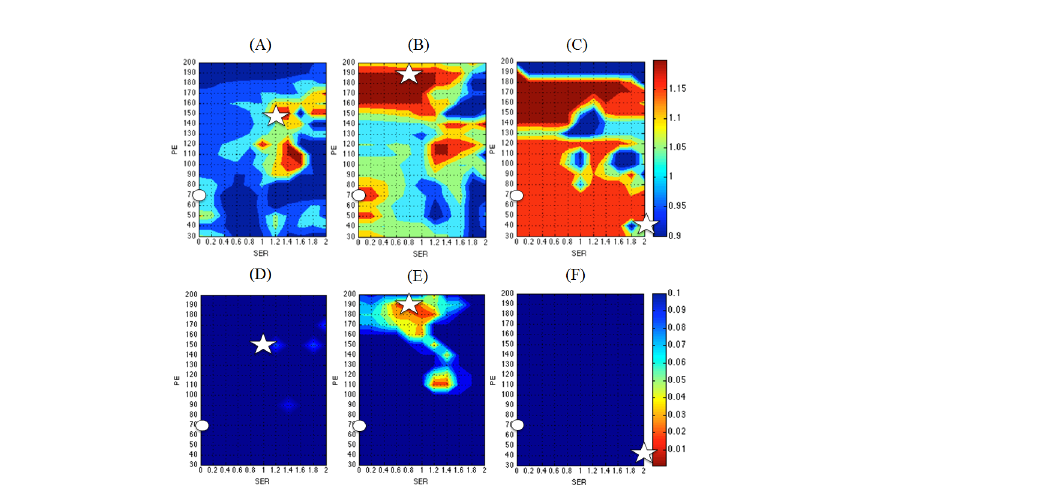
Fig 2. Heat maps for estimated hazard ratios (top panels) and p-values (bottom panels) of Δ FTV 2 in breast cancer subtypes. HR+/HER2-: hazard ratios (A) and p-values (D); HER2+: hazard ratios (B) and p- values (E); TN: hazard ratios (C) and p-values (F). Note that values with high hazard ratios and low p-values are coded in red. On all maps, the default settings with PE t = 70% and SER t = 0 were marked as circles, and the optimized PE t and SER t settings were marked as